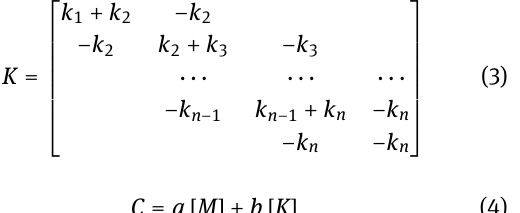
Figure 2: Analysis model of frame